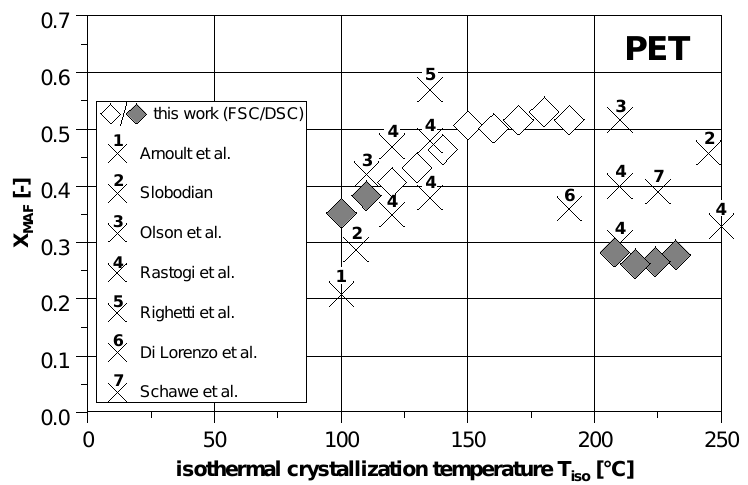
Figure 12. Comparison of the determined X MAF to the literature regarding the isothermal crystalliza- tion of PET. 1—[23]; 2—[21]; 3—[37]; 4—[5]; 5—[16]; 6—[22];